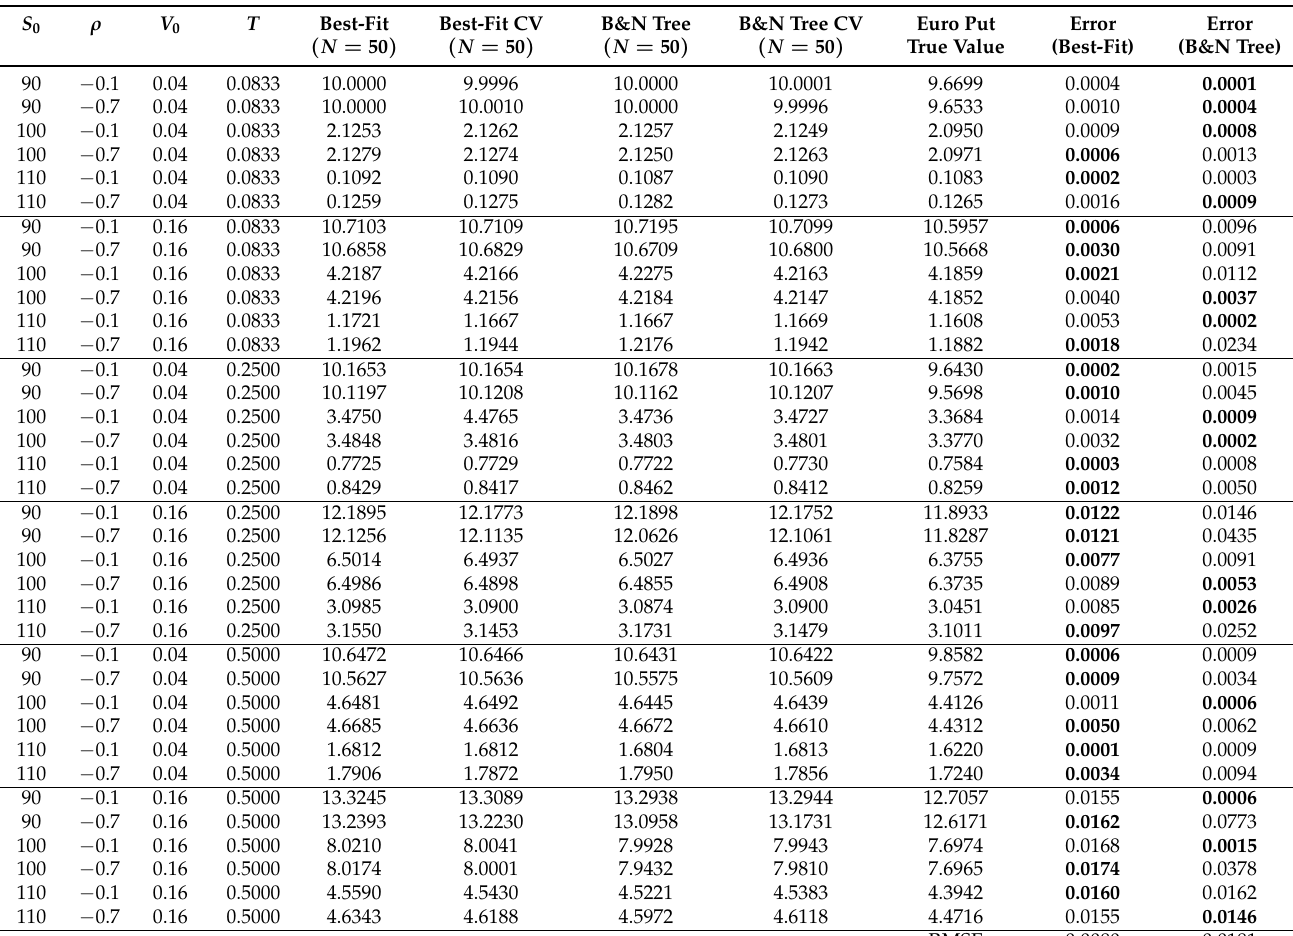
Table 6. American put price computed using Best-Fit model and control variate (CV) technique, compared with the result reported in Beliaeva and Nawalkha (2010).